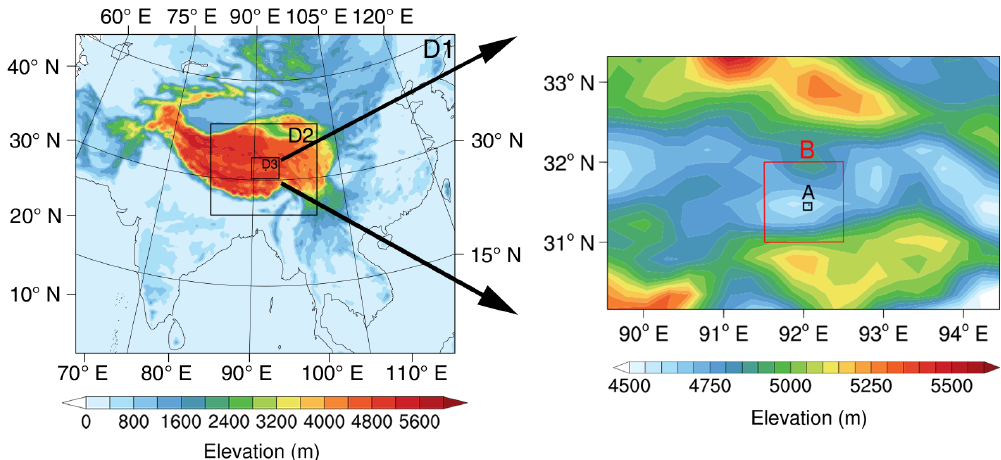
Figure 3. Color-filled map of the height field for simulated region (area A is marked with black rectangle, and area B is marked with red